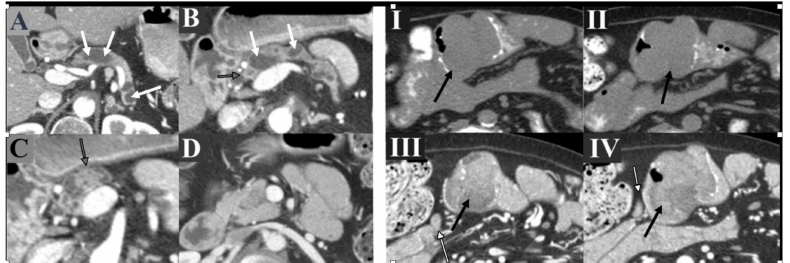
Figure 8. A 35-year-old female patient with known PJS. ( Left Panel ) Annual screening of CT ab- domen (Subpanels A – D ) showed diffuse dilatation of the main pancreatic duct (white arrows) with hypoattenuating polypoid lesions in the pancreatic region (black-bordered gray arrows). Biopsy with histopathological examination showed intra-ductal mucinous neoplasm (benign tumor). ( Right Panel ) Bulky soft tissue mass (black arrows) was incidentally identified along the proximal small bowel (Subpanels I , II ) with heterogeneous enhancement (Subpanels III , IV ) and regional lymphadenopathy (white arrows). Surgical excision of this mass revealed mucinous adenocarcinoma of the small bowel with lymph node